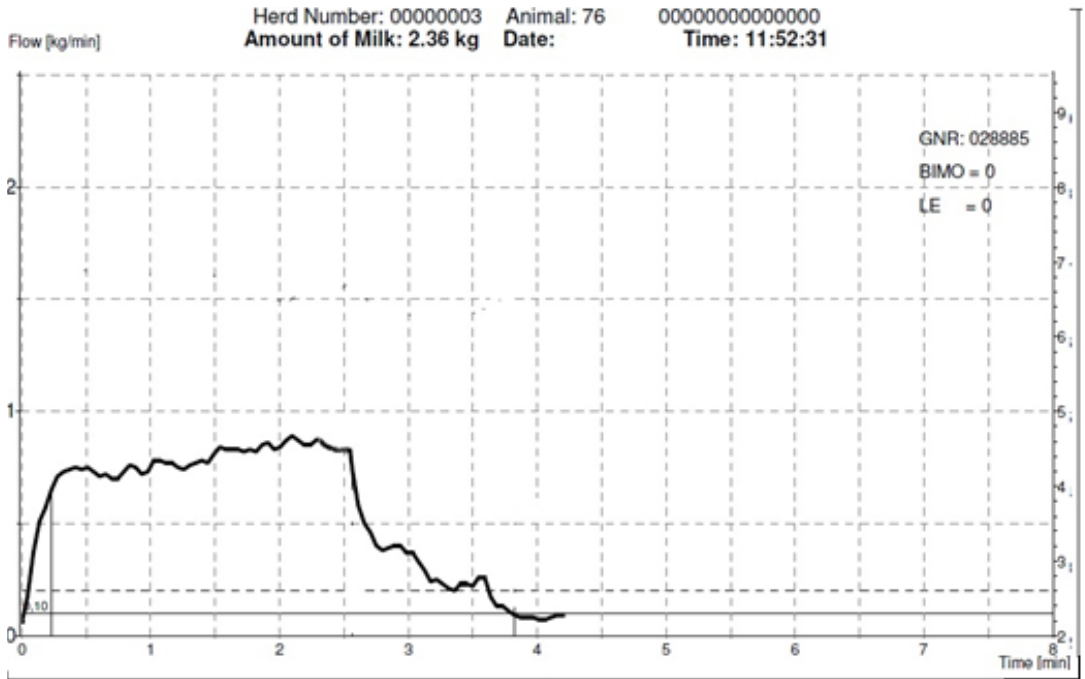
Figure 1. Milk emission curve recorded by the Lactocorder® devices (Lactocorder, Balgach, Switzerland) to show the emission curve that characterizes the Murciano-Granadina goat (long plateau phase).